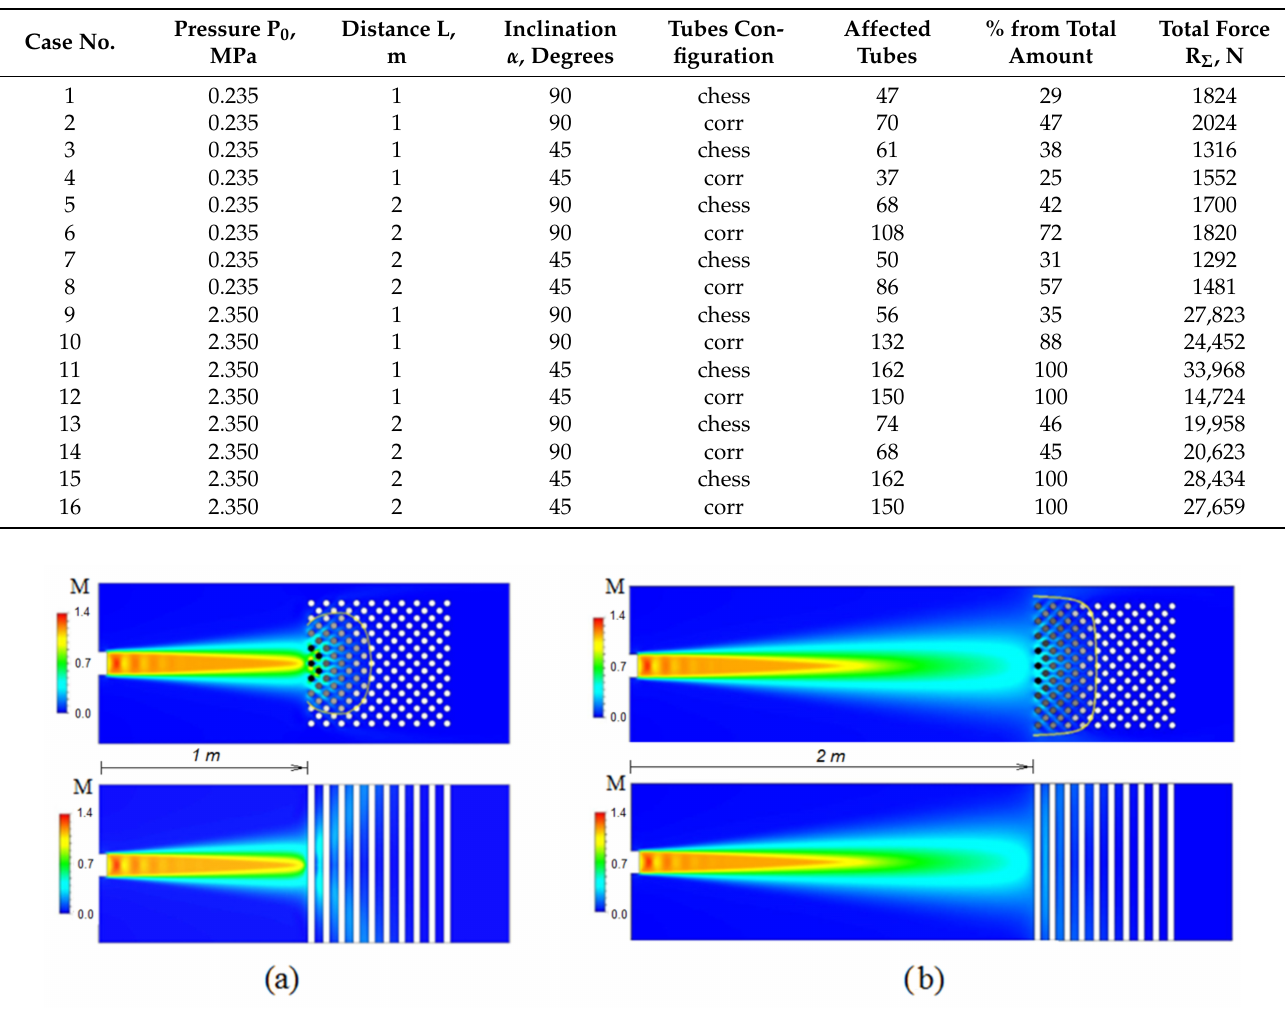
Table 1. Calculation cases for determination of the forces acting on heat exchange tubes.